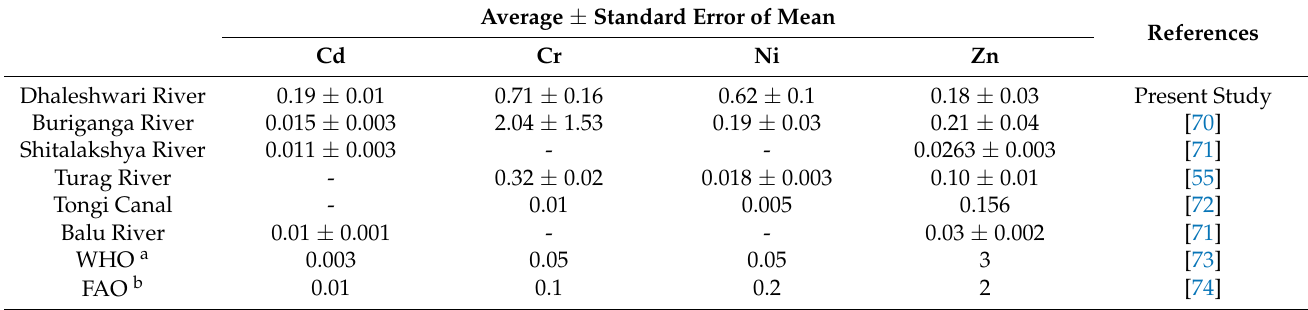
Table 5. Heavy Metals Concentration (mg/L) levels of the water samples of the Dhaleshwari River and the other peripheral rivers in Dhaka